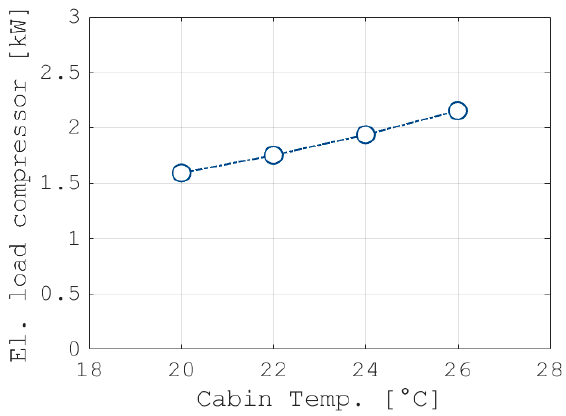
Figure 13. Electrical load of the compressor vs. the cabin temperature. Figure 12. PMV value vs. the cabin temperature: (left) driver; (right) co-driver.